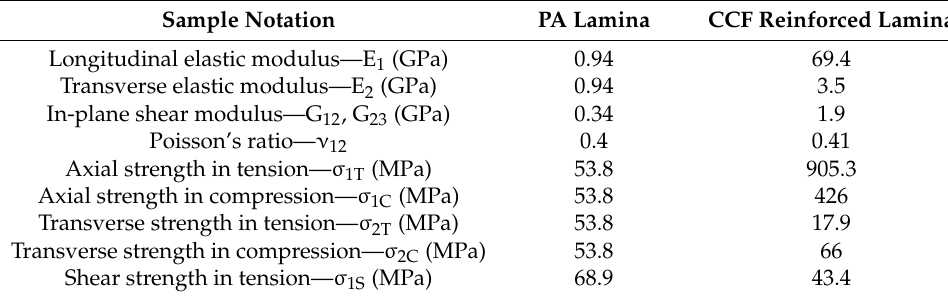
Table 3. Elastic constants and strength properties of neat PA [29] and CCF reinforced laminae [20] adopted for VAS and CLT